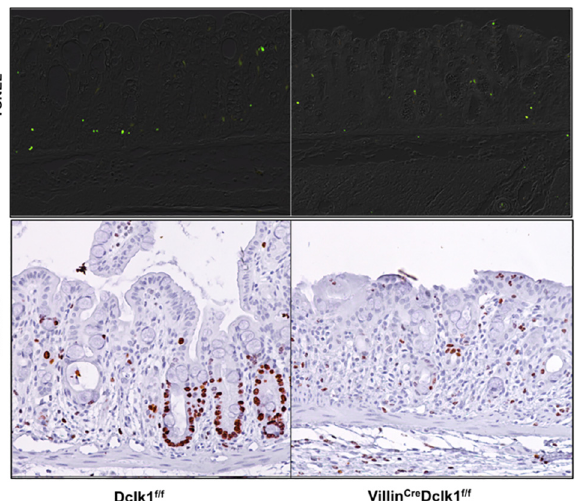
Fig 3. Deletion of Dclk1 increases epithelial apoptosis and decreases epithelial proliferation following DSS treatment. A. Apoptotic cells (Green) identified by TUNEL assay; B. Proliferative cells identified by immunostaining with anti-Ki67